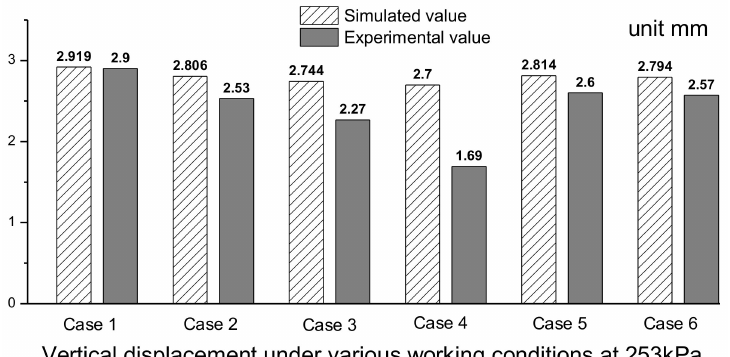
Figure 6. Simulated values and experimental values of vertical cumulative settlement under different